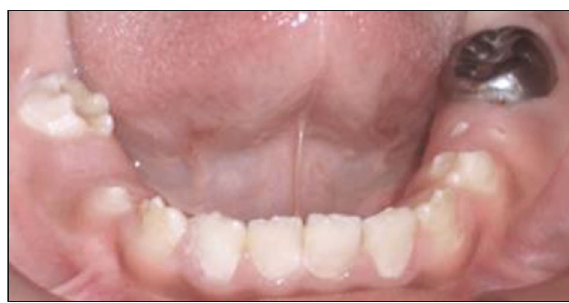
Figure 6: Intraoral lower occlusal.